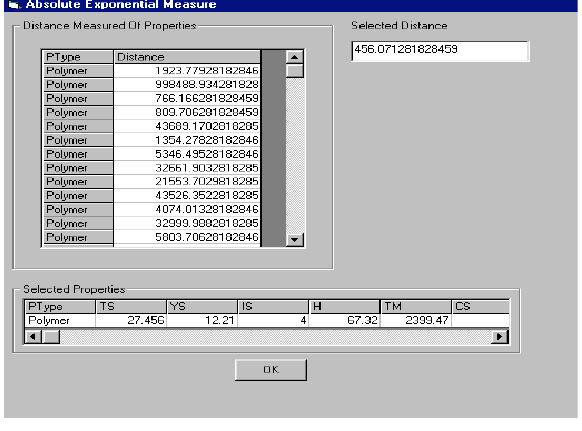
Fig. 6(b): Materials selected using Absolute Exponential Measure.